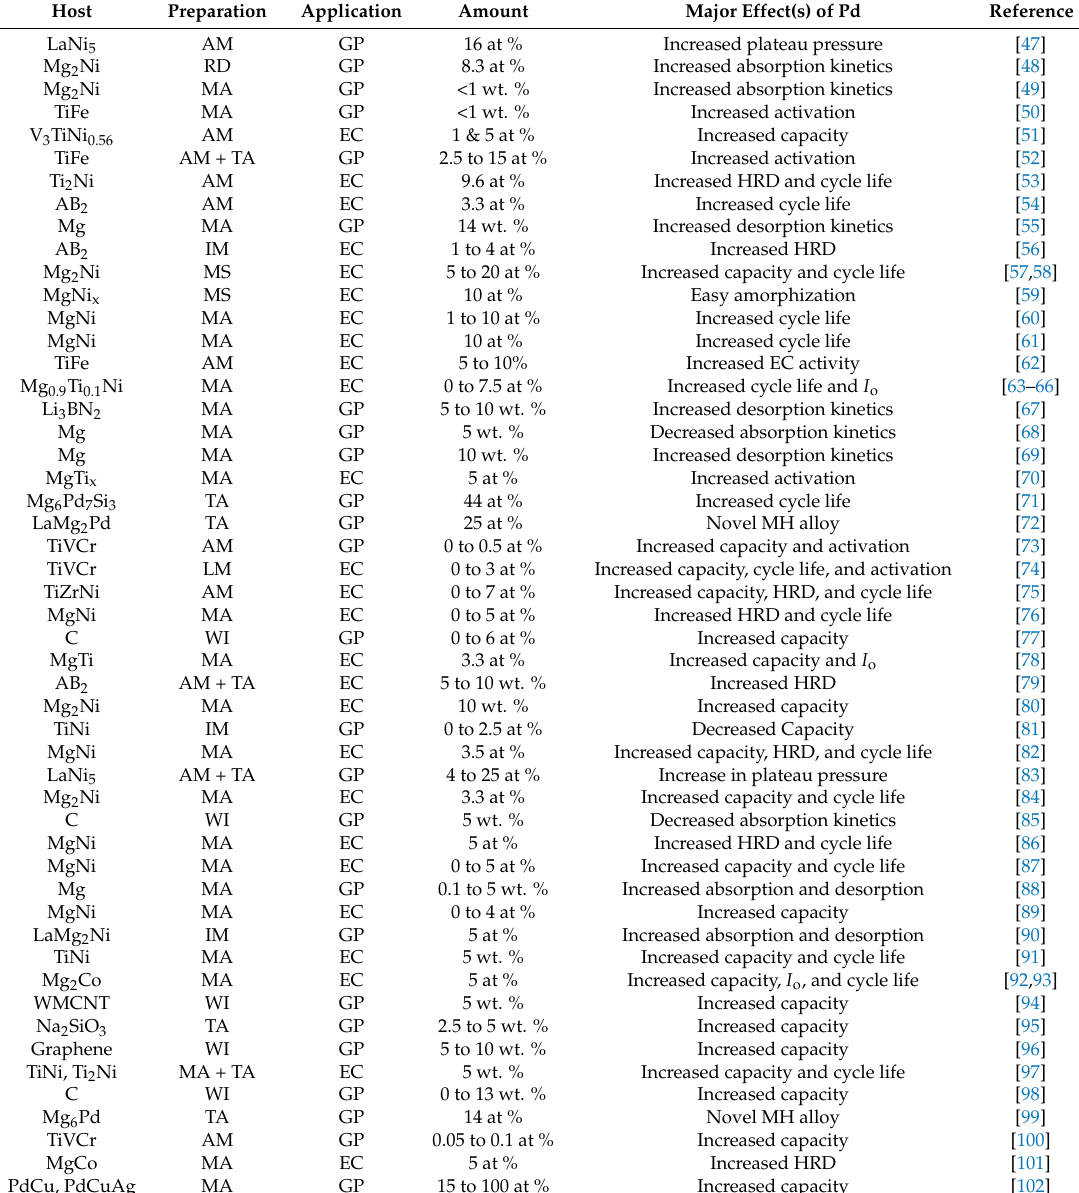
Table 1. Summary of the Pd-substitution research based on different preparation methods, including arc melting (AM), replacement diffusion (RD), mechanical alloying by ball milling (MA), thermal annealing (TA), induction melting (IM), melt spinning (MS), levitation melting (LM), and wet impregnation (WI), in chronological order. GP and EC denote gaseous phase and electrochemical applications, respectively. HRD and I o represent high-rate dischargeability and surface reaction current,